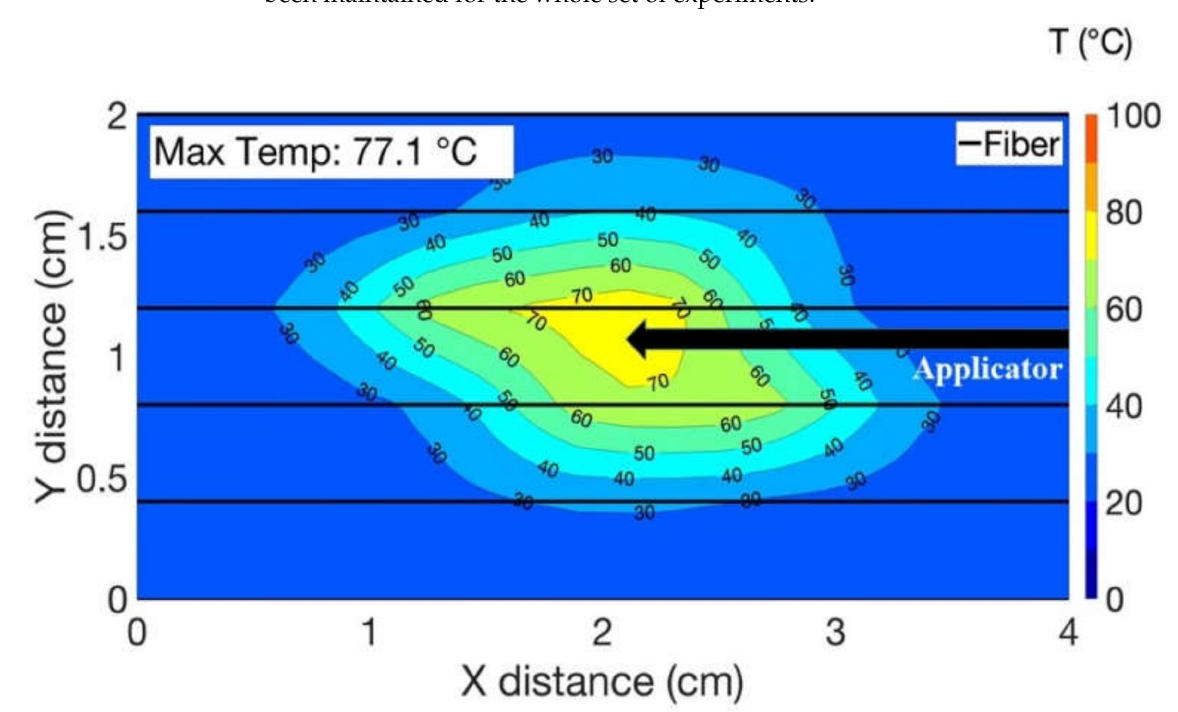
Figure 5. 2D thermal map presenting the heating outcome of the phantom injected with agarose gel during RFA and with the blood-vessel-mimicking medical tube located in parallel to the optical